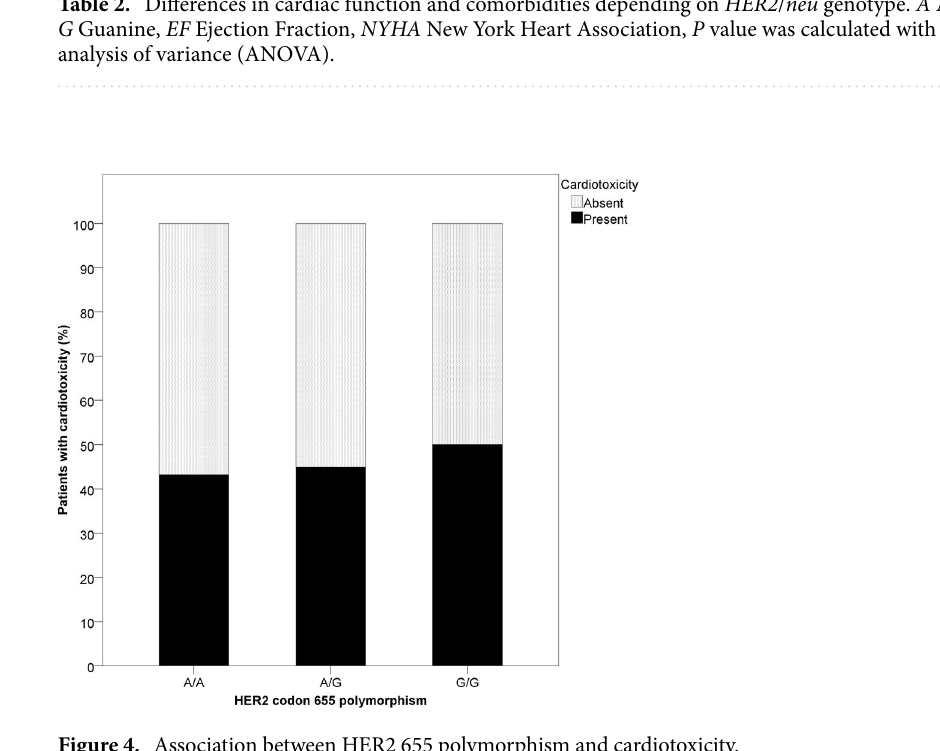
Figure 4. Association between HER2 655 polymorphism and